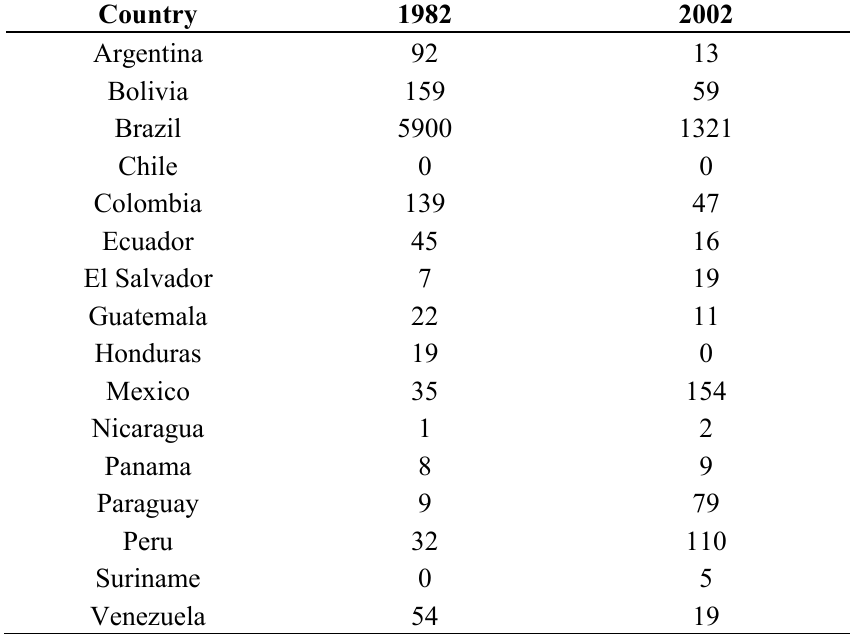
Table 2. Bovine rabies in Latin America in 1982 and 2002 (data from the Pan American Health